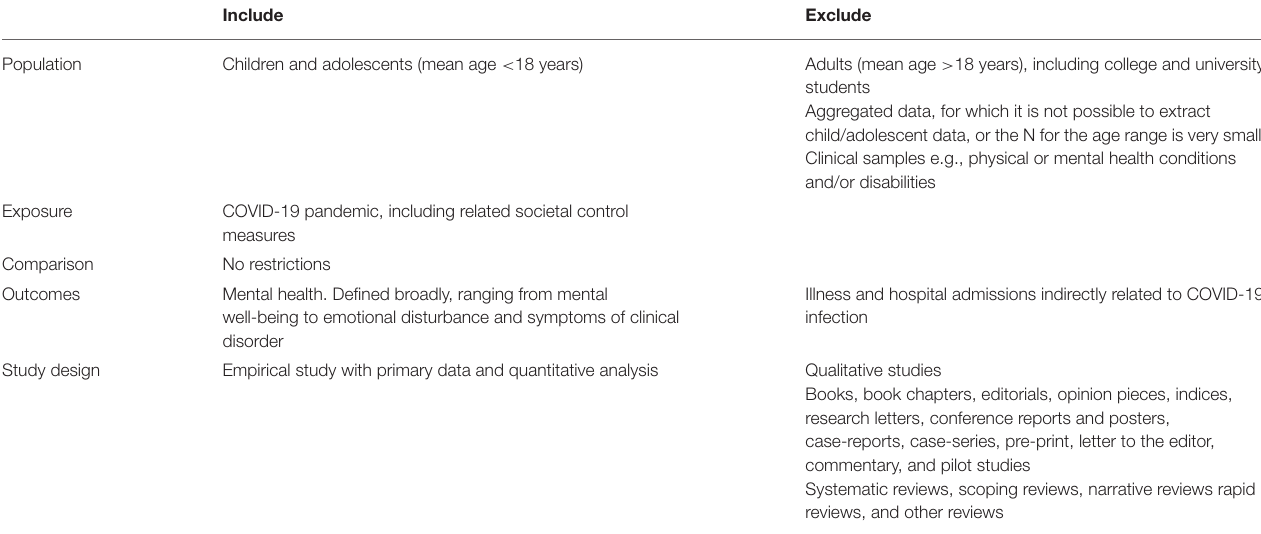
TABLE 1 | Scoping review eligibility criteria.